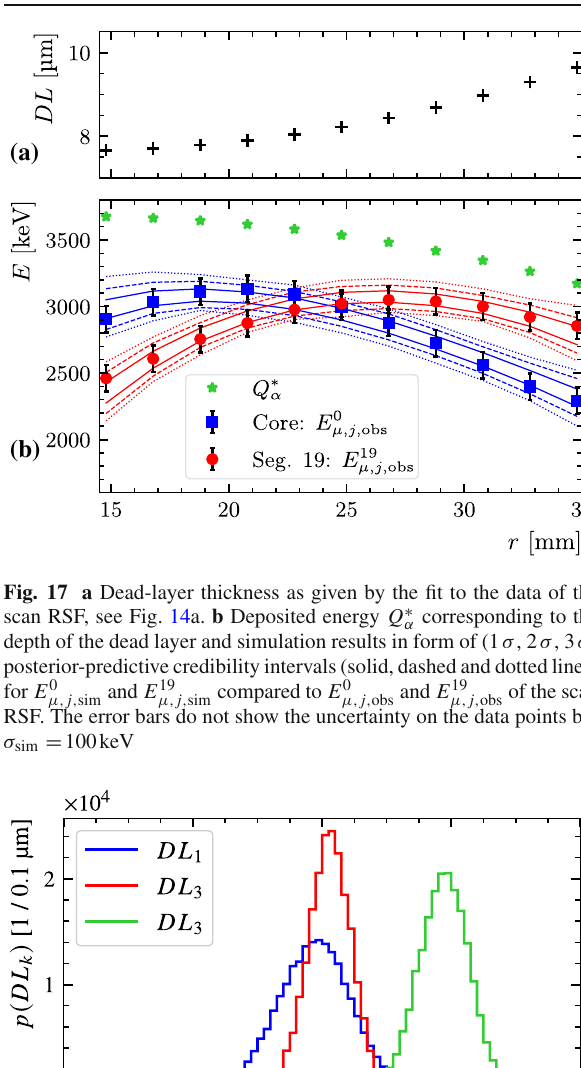
is about a factor of three higher for electrons than for holes.